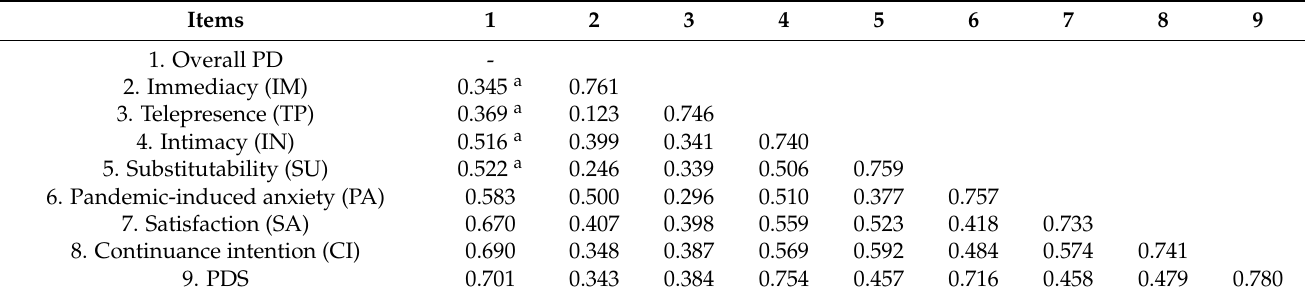
Table 4. Pearson product–moment correlation